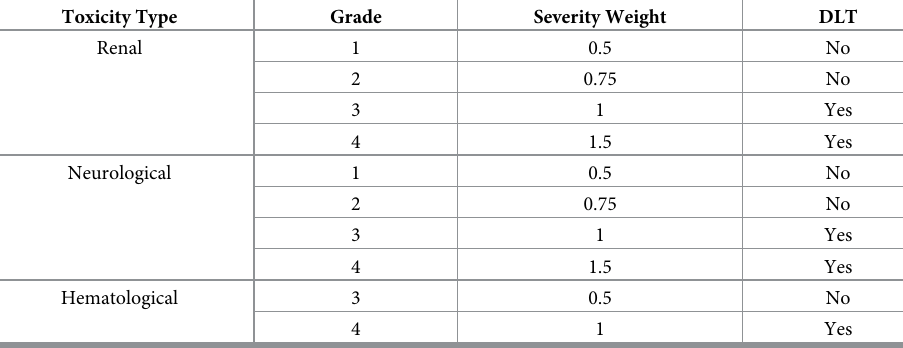
Table 1. Toxicities and severity weights in the example